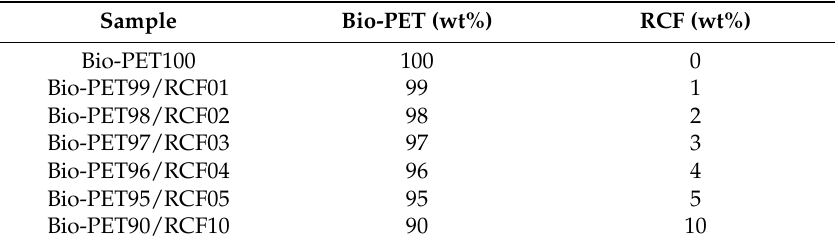
Table 5. Codification and composition of the samples according to the content of bio-based polyethylene terephthalate (bio-PET) and recycled cotton fiber